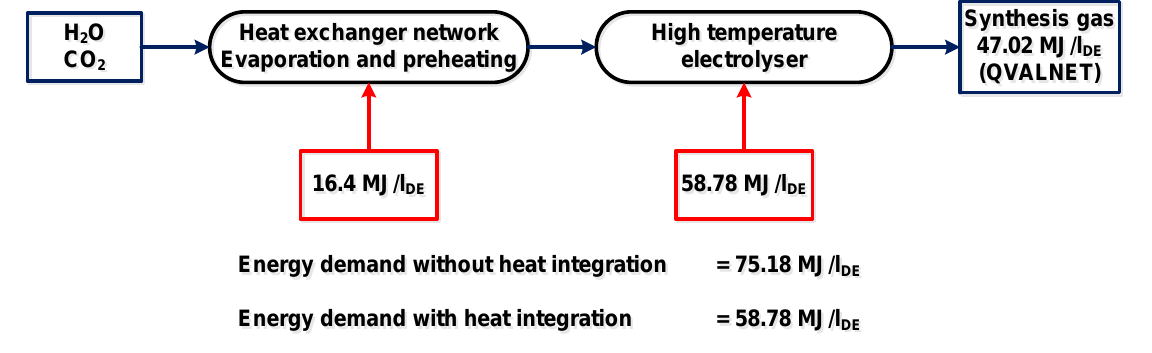
Figure 12. Simplified balance for co-electrolysis.